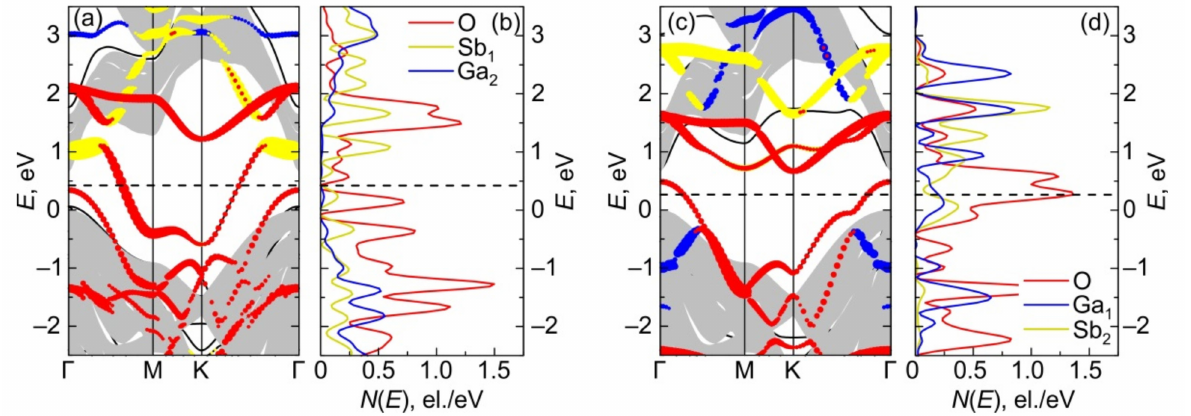
Figure 10. Electron energy spectra ( a , c ) and local density of states of surface atoms ( b , d ) in the case of GaSb(111)B surface with three O adatoms in Ga-B positions ( a , b ) and GaSb(111)A surface with three O adatoms in Sb-B positions ( c , d ). The surface states localized on Ga, Sb, and O atoms are shown by blue, yellow, and red balls, respectively. The denotations of the zero energy, the bulk states, the Fermi level, and the size of balls are the same as in Figure